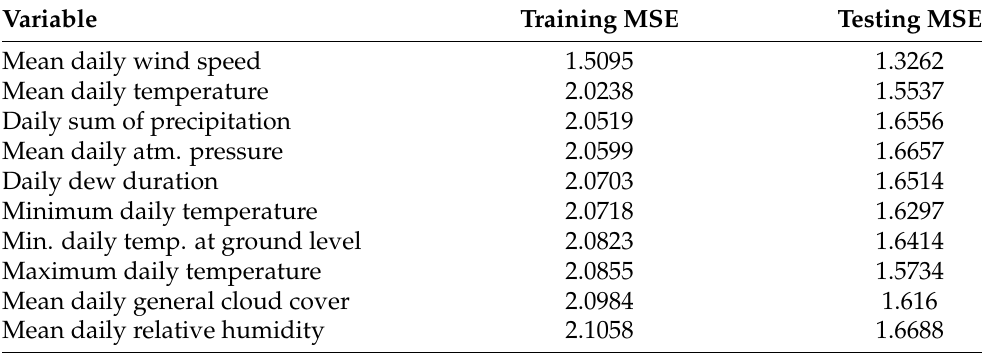
Table A11. The results of the selection of the most suitable subset of training variables for the prediction of the daily sum of precipitation.